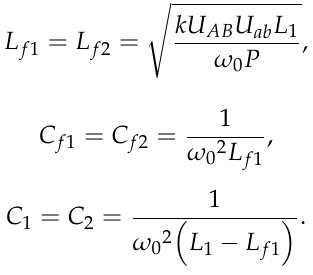
Table 4. Parameters of compensation circuit.